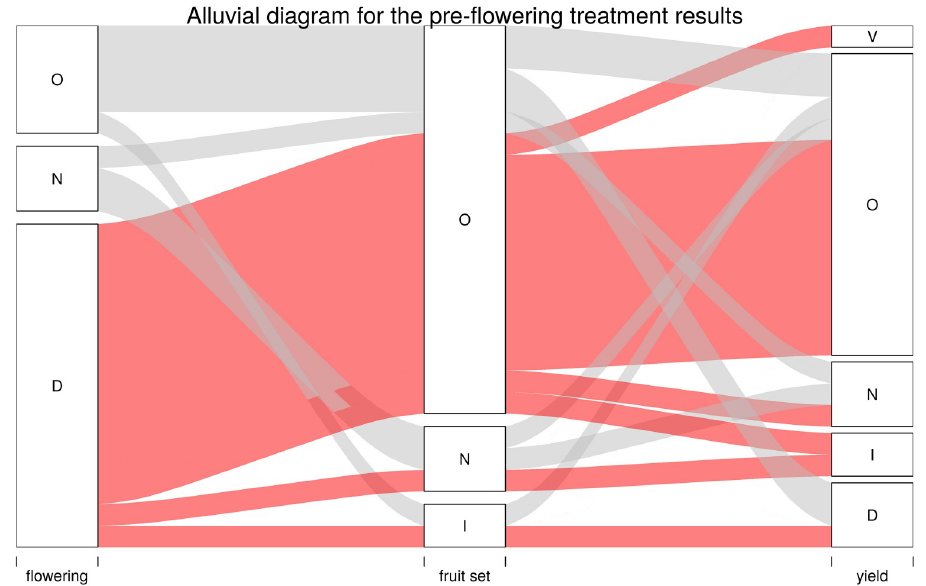
Fig 8. Alluvial diagram for the pre-flowering treatment results. Only the pre-flowering treatment studies were considered. The effect of GA pre-flowering treatments on flowering, fruit set and yield for each reviewed publication was noted as follows: N, no effect; I, increase; D, decrease; O, not studied and V, variable result. Bandwidth reflects the number of publications. The narrowest bandwidth represents a single publication. Red denotes the articles in which GA decreased flowering, while gray denotes the articles in which GA had a different